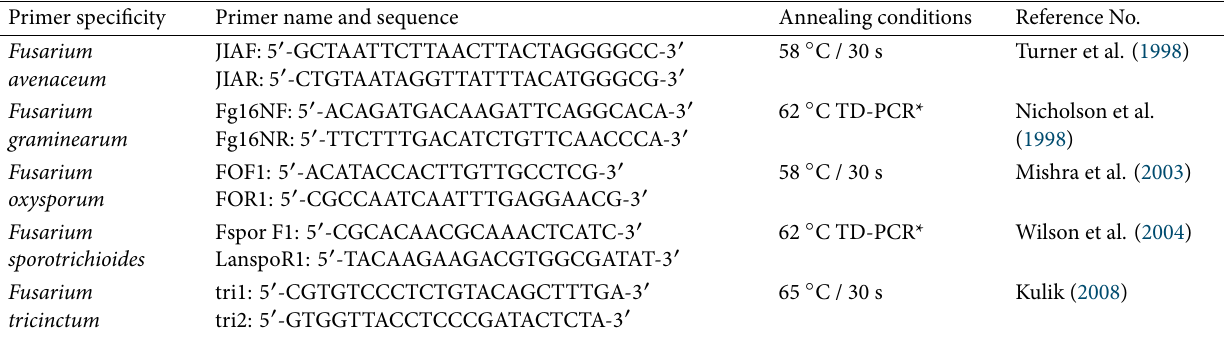
Table 2 Names, sequences, annealing conditions, and references of primers for Fusarium species analyzed in species-specific PCR